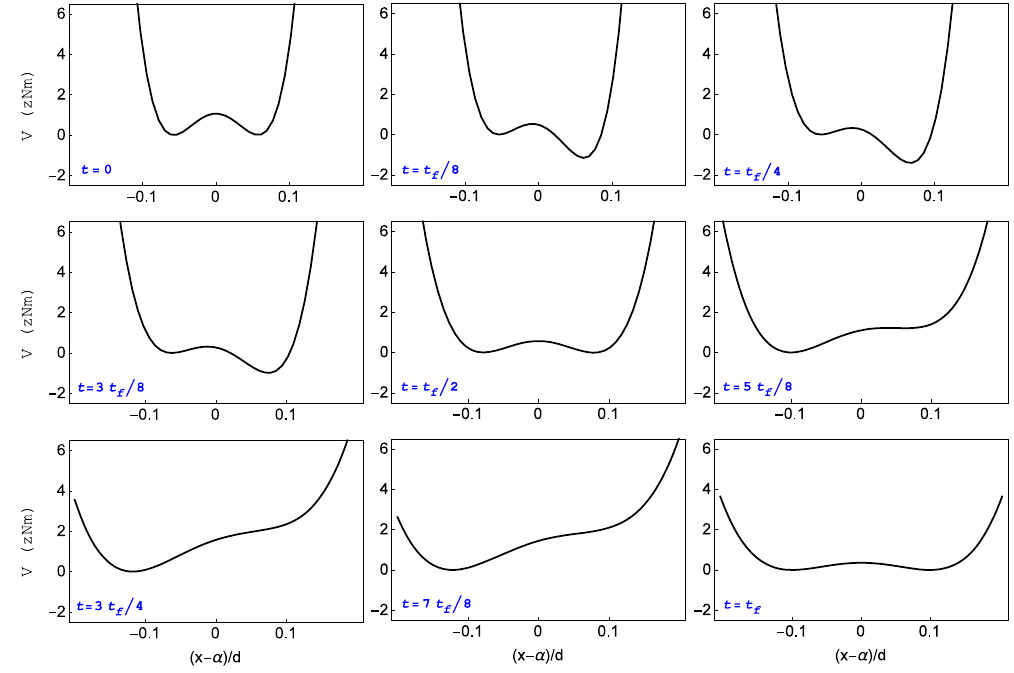
Figure 3. Time evolution of the shape of the launching double-well potential with velocities = v 10 m/s and f ε = s 2/ . Each snapshot has been vertically displaced, without affecting the dynamics of the system, so that the minimum of the left well always lies at zero potential. The parameters used are λ = − . 4 7 pN/m, β = . 5 2 mN/ μ s. Even though not appreciated by the naked eye in the m 3 , µ = . 86 4 zN, = d 370 μ m, γ = 3 and = t 1 f